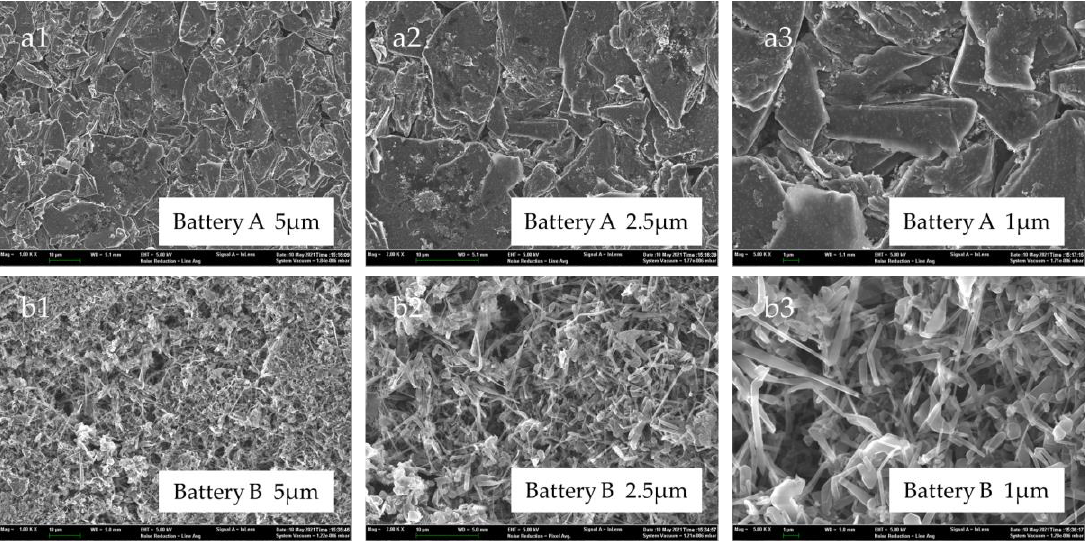
14 of 24 Figure 7. ( a ) The current parameters adopted in aging tests; ( b ) the battery temperature evolution during the repeated preheating, as well as the battery clamp.